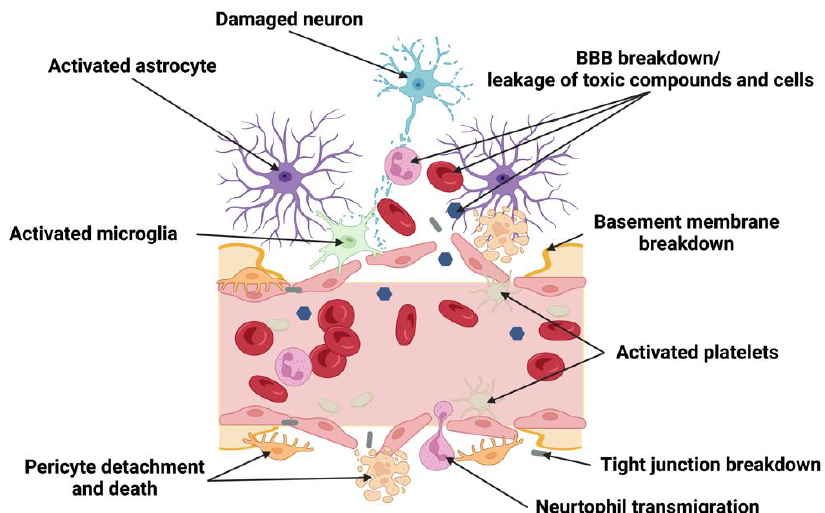
Figure 2. NVU dysfunction following ischemic stroke. A decrease of the cerebral perfusion leads to neuronal injury and death, causing an increase in the release of proinflammatory mediators that activates the components of NVU. Activated endothelial cells attract leukocytes, leading to their increased transmigration across the breached BBB and subsequent neuroinflammation. MMPs produced by activated endothelial cells and pericytes degrade the basement membrane, together with the tight junction breakdown they result in leakage of toxic compounds via BBB opening. Microglia dynamically transition into reactive and surrounding brain–blood vessels and exacerbate BBB breakdown, while activated astrocytes secrete proinflammatory mediators that cause further NVU disruption and neuronal injury. Furthermore, pericytes detach from vessel wall or die, further exacerbating BBB function and impair blood flow regulation.